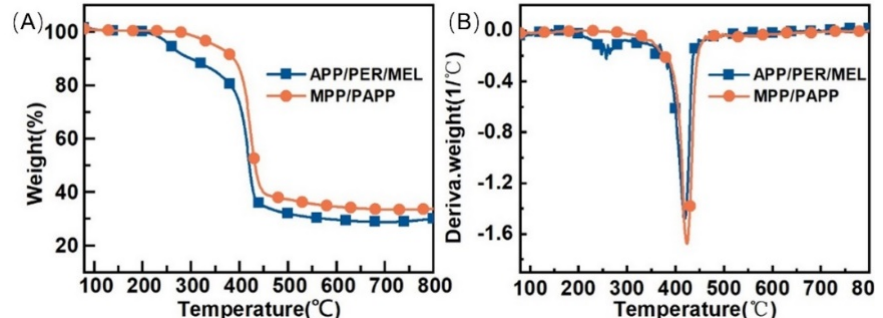
Figure 3. ( A ) The weight change of the coatings immersed in distilled water. ( B ) Water contact angle of IFR and ICs.